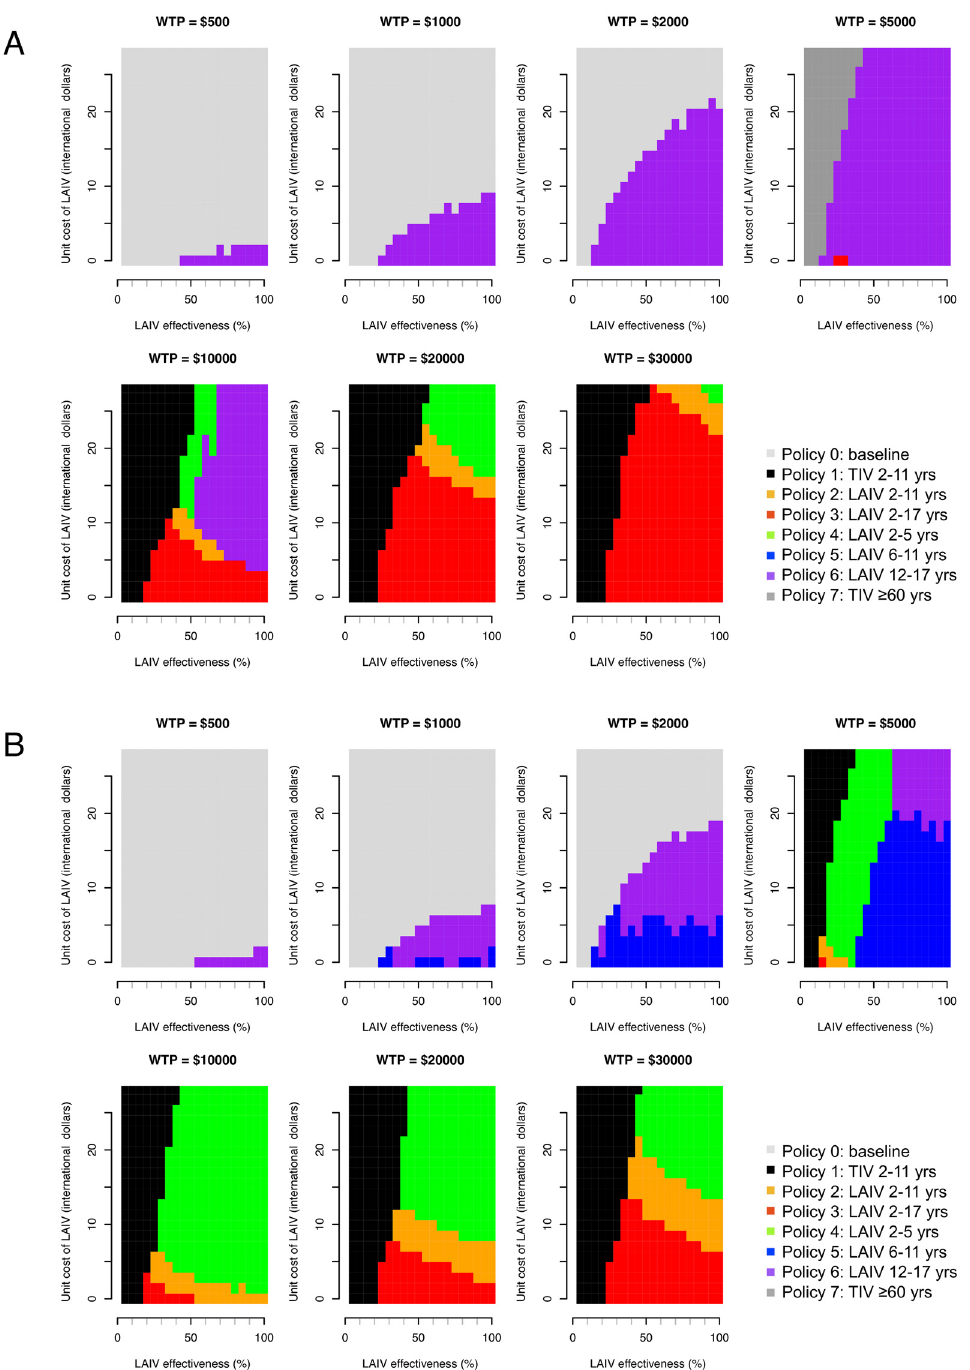
Fig 4. Threshold analysis. Figure shows how the optimal policy (defined as the policy that maximizes the INB) changes with LAIV effectiveness, unit cost of LAIV, and willingness to pay (WTP) per DALY averted (cost-effectiveness threshold). (A) Base case mixing matrix. (B) Contact matrix based on physical contacts